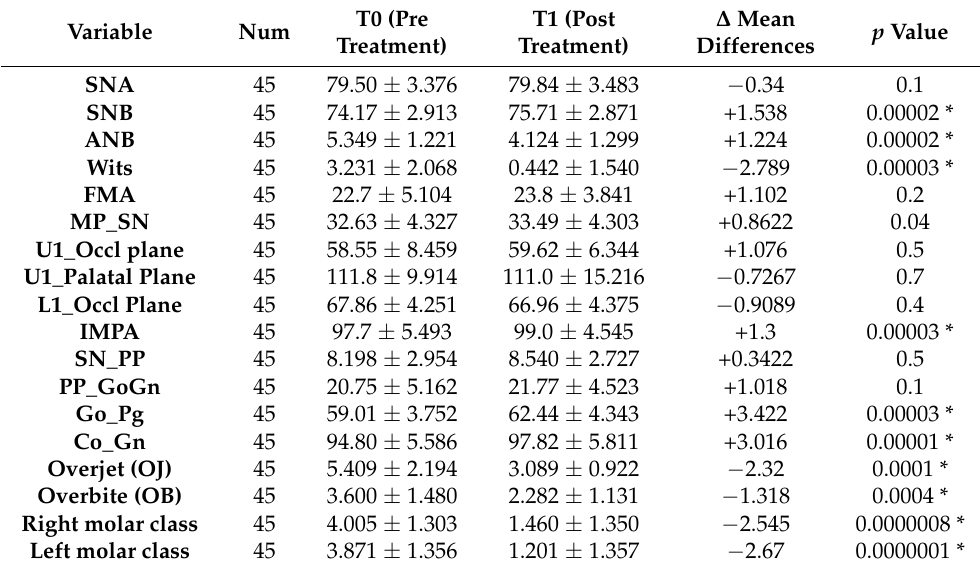
Table 5. Descriptive information (mean/standard deviation for each value) at T0 and T1, and relative statistical significance ( p < 0.05